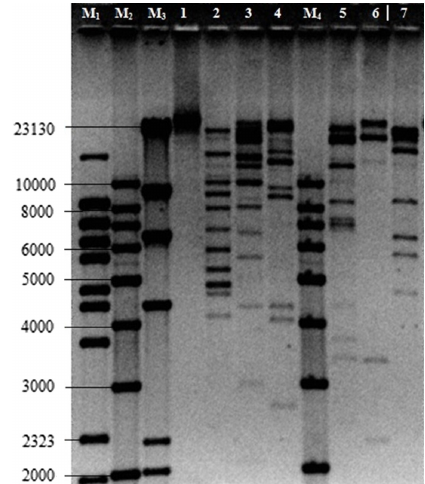
Figure 4. Restriction endonuclease digestion profiles of phage Enteroc21. M1, λ BstE II DNA marker; M2 and M4, GelPilot 1 kb DNA marker; M3, λ Hind III DNA marker. (1) Uncut phage DNA, (2) phage Enteroc21 Hin dIII, (3) Ava I, (4) Pst I, (5) Eco RI, (6) Bst EII, and (7) Nco